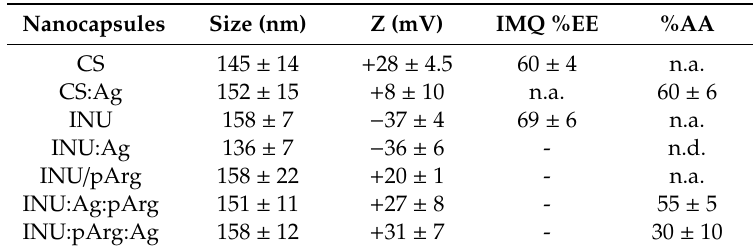
Table 2. Physicochemical characterization, Imiquimod encapsulation e ffi ciency, and antigen absorption of the di ff erent nanocapsules’ prototypes.